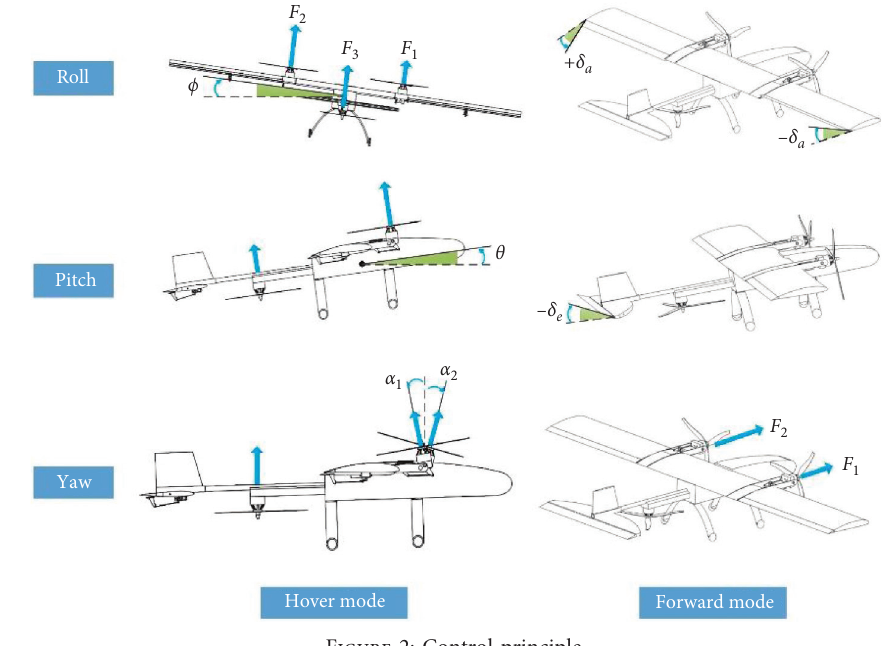
Figure 2: Control